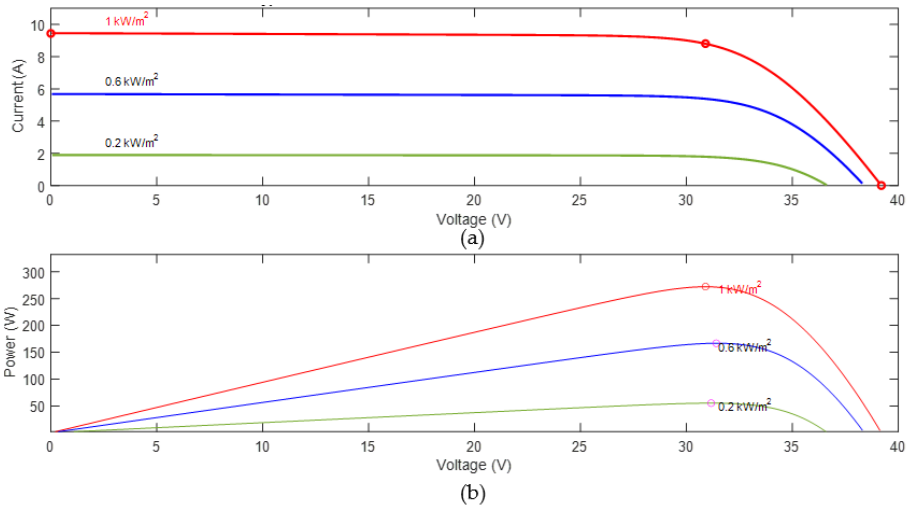
Figure 2. ( a ) I ‐ V and ( b ) P ‐ V characteristics of a solar module under varying solar radiation [21,22].